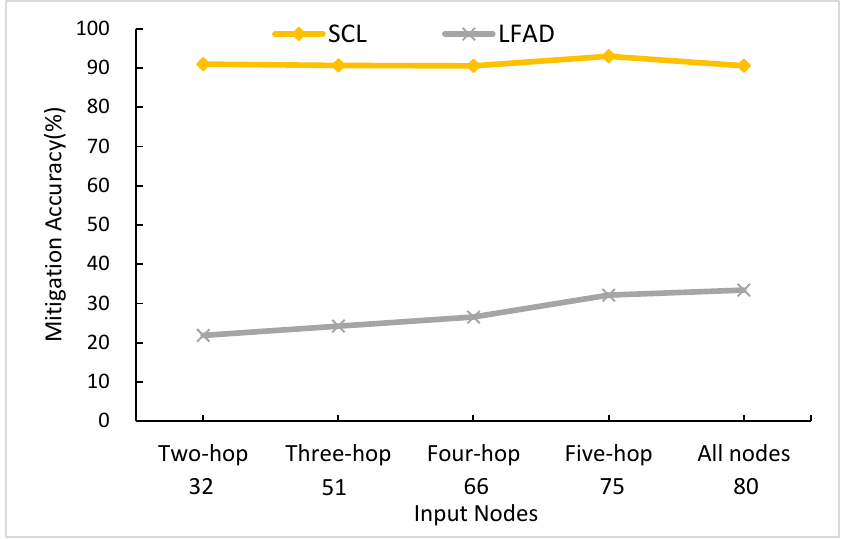
Figure 17. Comparison of the number of target links.